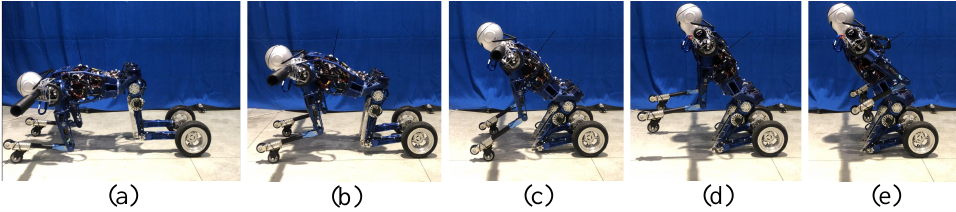
Figure 16. The transition of robot posture from crawling on all limbs to kneeling: ( a ) Crawling on limbs; ( b – e ) From crawling to